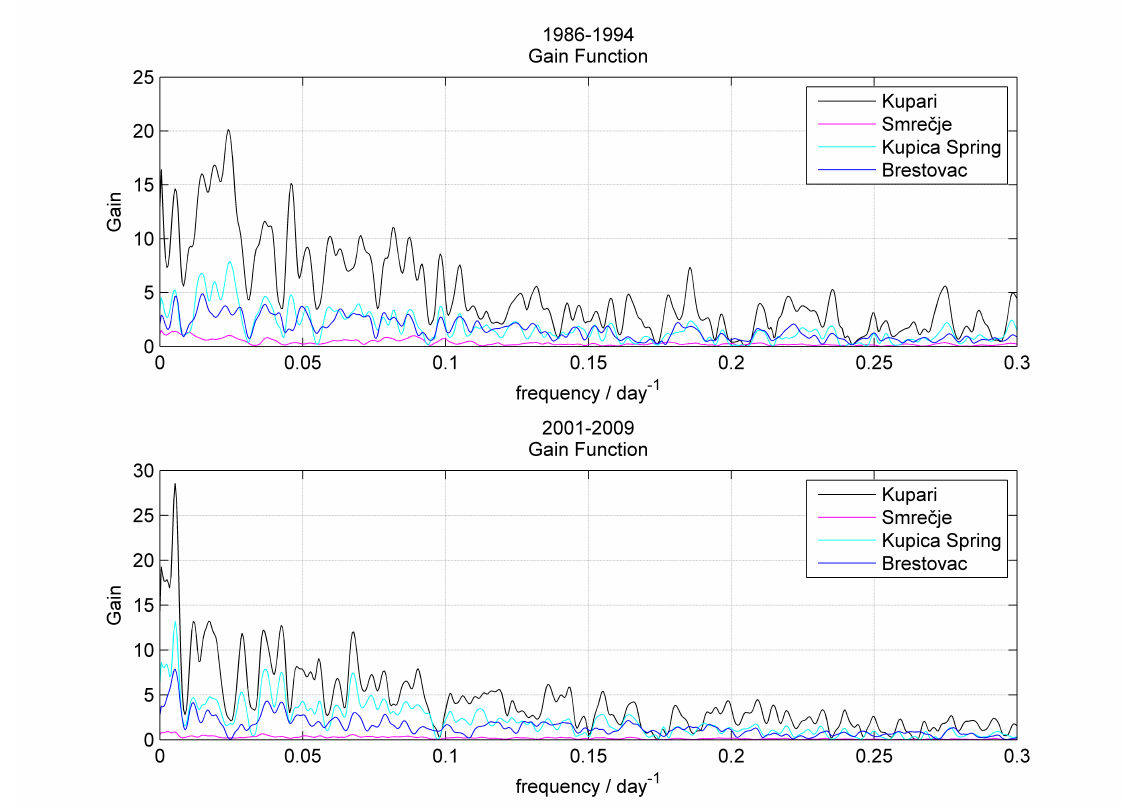
Figure 8. The gain function obtained for the studied hydrological and meteorological stations for the two analyzed